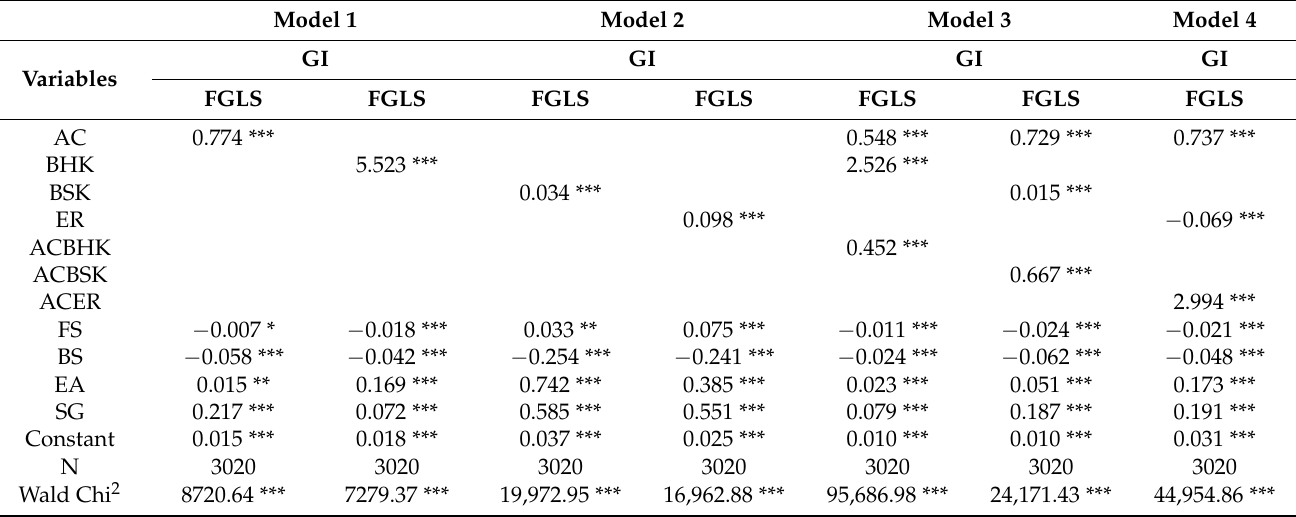
Table 4. The Result of the